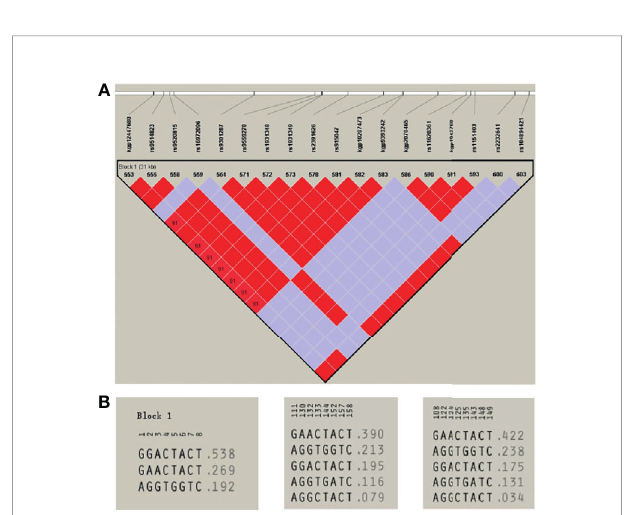
FIGURE 6 | (A) Haploview-generated linkage disequilibrium (LD) patterns for the LIG4 mutation c.833G>T (p.R278L) and the predicted block structure. The rate of LD is represented by different colors (the highest rate of LD is red, the lowest in purple). (B) Potential haplotypes of the eight selected SNPs genotyped in our study in Patients (left) and in CHS (middle) and CHB (right)